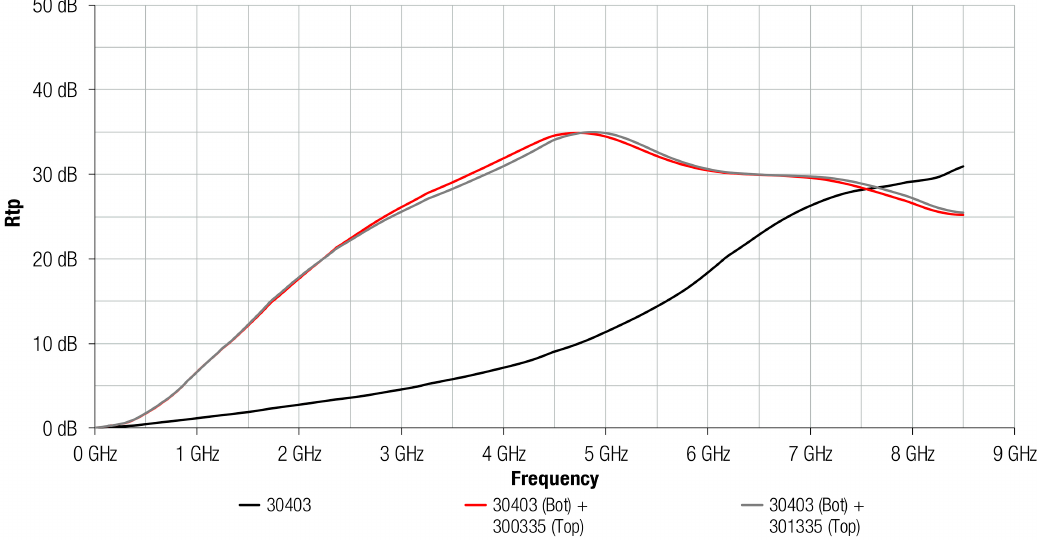
Figure 5. R tp of 30403 absorber sheet without any metal layer (black), 30403 absorber sheet with a Cu layer attached (red) and 30403 absorber sheet with a Al layer attached (grey).